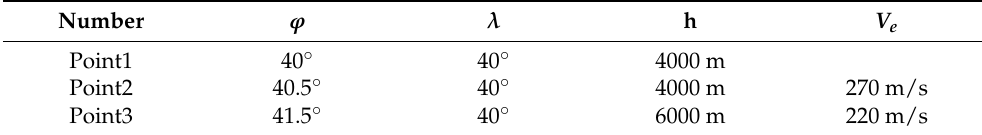
Table 6. Waypoint settings in Section 5.3.